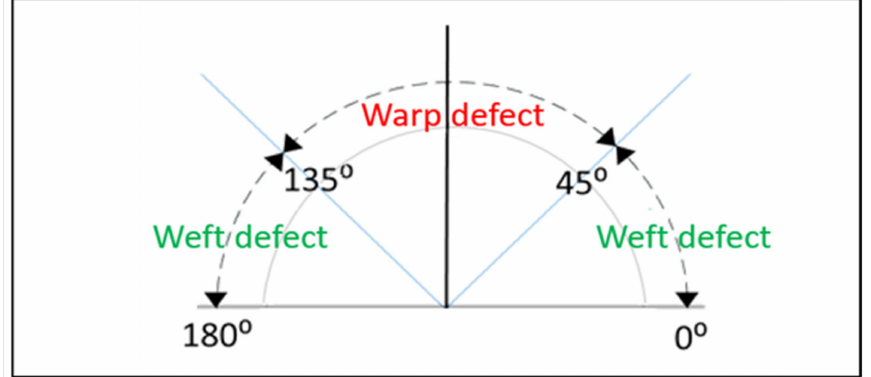
Figure 4. Defect directionality: range of angles of warp and weft defects.